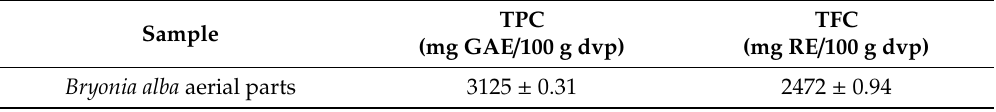
Table 2. Quantification of the total phenolic content (TPC) and total flavonoid content (TFC) in the aerial parts of Bryonia alba L. (mg GAE or RE / 100 g dvp).